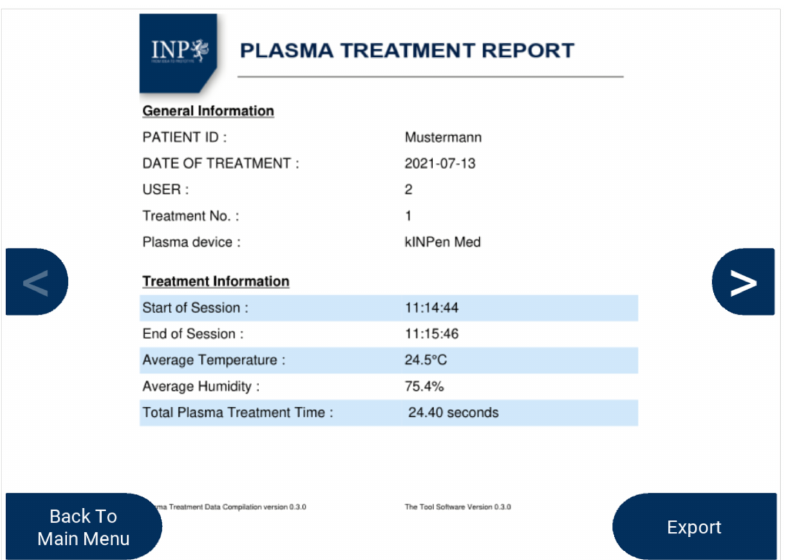
Figure 10. Example of the generated plasma treatment